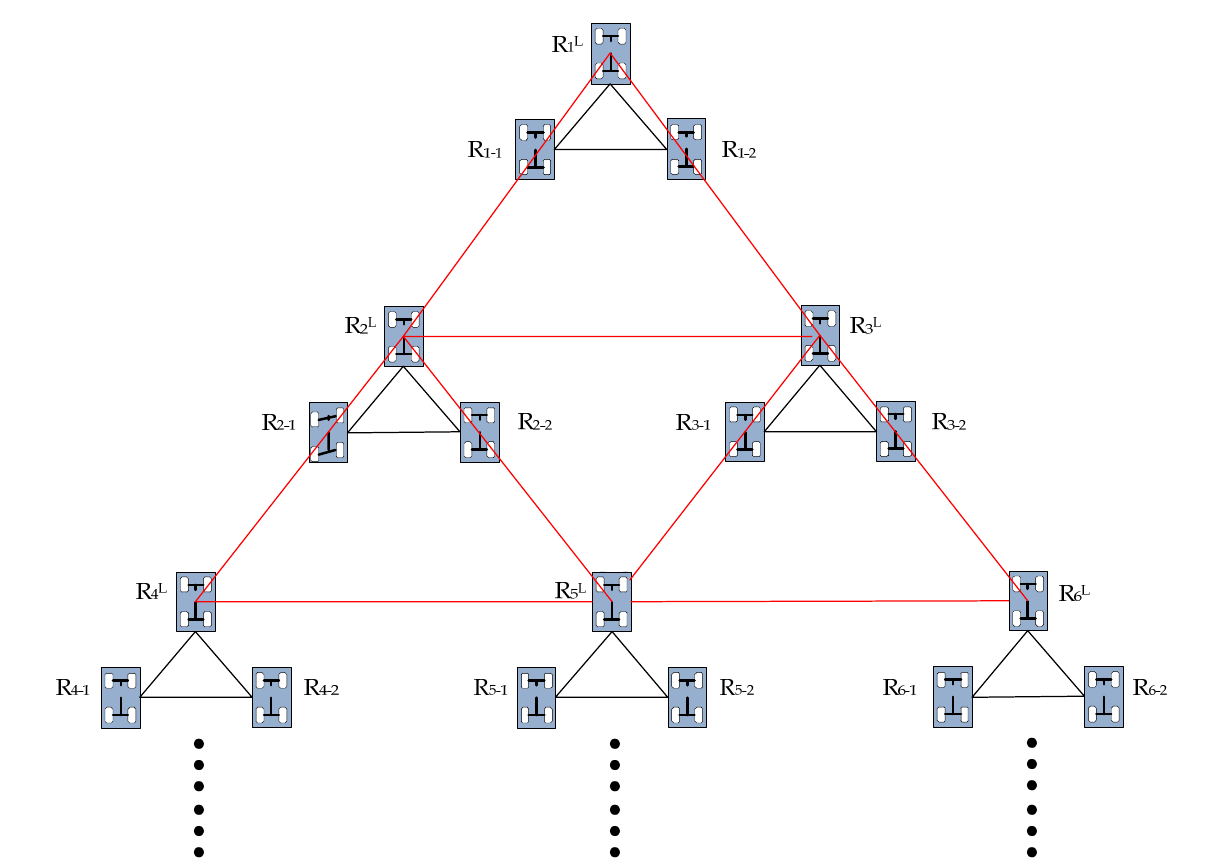
Figure 4. Communication topology of grouping consistent formation.